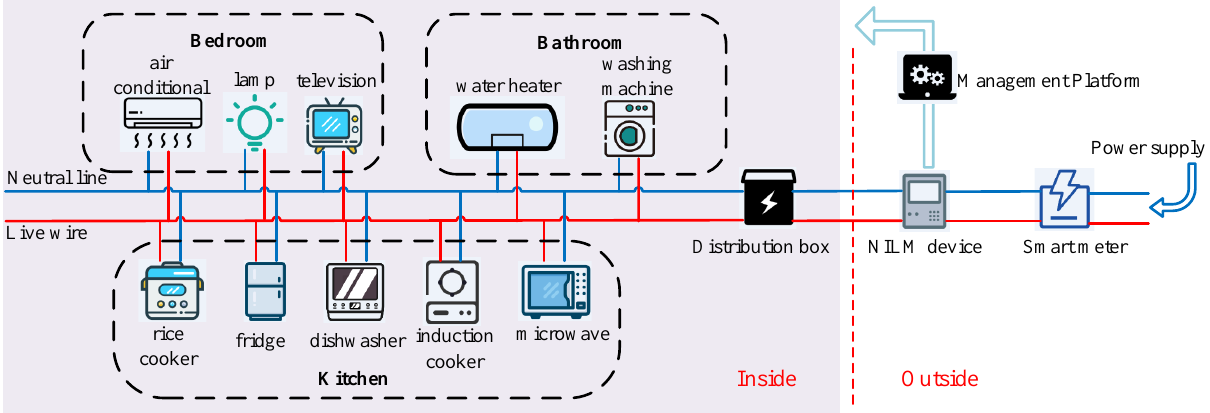
Figure 1. The physical architecture of non-intrusive load